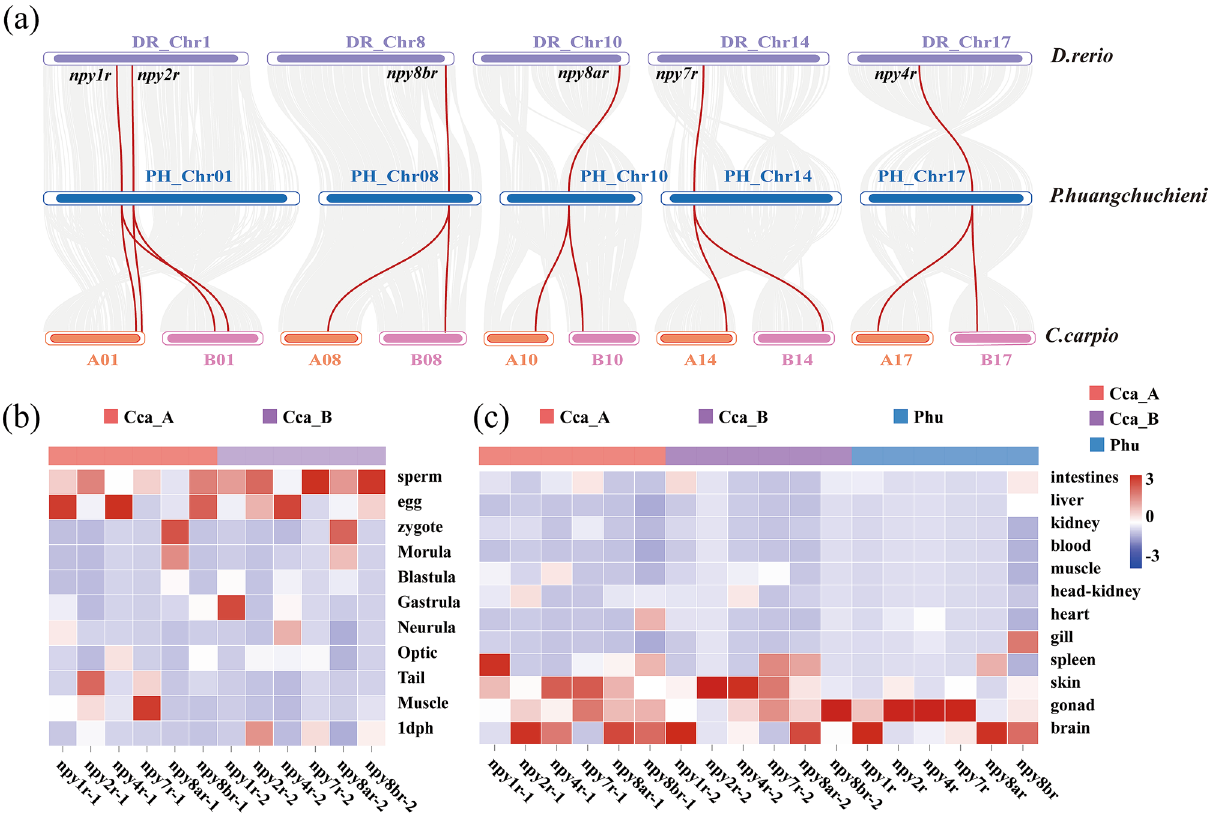
Figure 5. Chromosomal distribution and comparative expression profiles of NPY-family receptor genes from diploid reference species and subgenomes of allotetraploid C. carpio . ( a ) Chromosomal distribution and synteny plot of npyrs from three species of Cyprinidae. Gray lines indicate synteny blocks within diploid D. rerio and allotetraploid C. carpio and its B-subgenome progenitor-like diploid P. huangchuchieni , and red lines highlight the npyr gene pair. ( b , c ) The comparative expression profile between allotetraploid C. carpio subgenomes and its B-subgenome progenitor-like diploid P. huangchuchieni. The left heatmap shows subgenome comparative expression patterns of npyr genes during common carp embryo developmental stages, and the right heatmap displays the tissue-specific comparative expression profile of npyr genes among subgenomes of allotetraploid C. carpio and its B-subgenome progenitor-like diploid P. huangchuchieni , both with stage and tissue names listed on the right side of the panel, and all npyr gene names in C. carpio are listed at the bottom of the